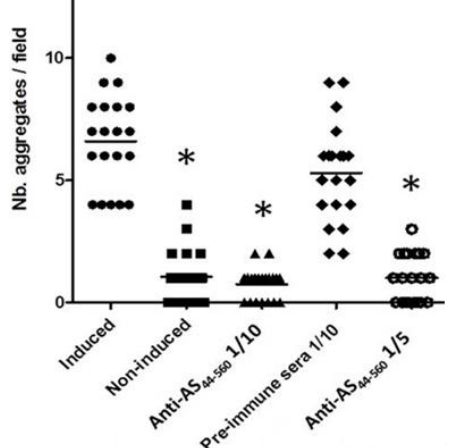
( a ) Non-induced; ( b ) Induced; ( c ) with pre-immune serum; ( d ) with antiserum Agg 1/10. Magnification of 400×. The same observation was made with antiserum Agg 1/5 as for the dilution 1/10 (data not shown). Figure 5. Interference in the formation of aggregates of E. faecalis 543 using anti-AS antibodies by